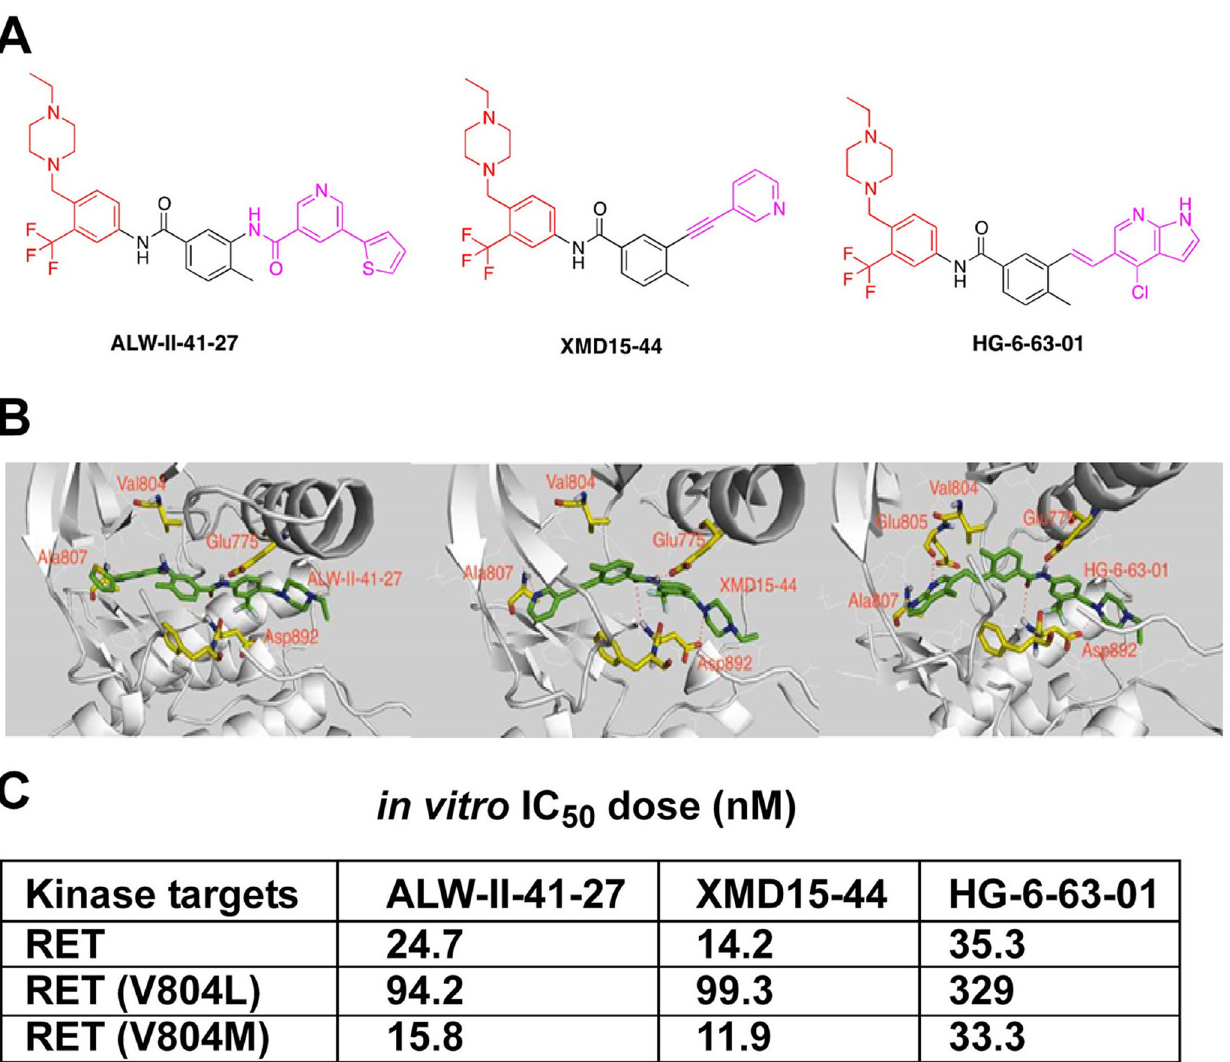
Fig 2. ALW-II-41-27, HG-6-63-01 and XMD15-44 chemical structure. A) Chemical structure of the studied compounds: red colour indicates the “ tail ” , black colour indicates “ linker ” , and pink colour indicates the “ head ” part in the binding. B) Modelling of ALW-II-41-27 (left), XMD15-44 (middle) and HG-6-63-01 (right) binding to the DFG-out conformation of RET. C) IC 50 dose (nM) of ALW-II-41-27, XMD15-44 and HG-6-63-01 for wt RET, RET/V804L and RET/V804M in vitro kinase activity measured by Invitrogen SelectScreen assay.